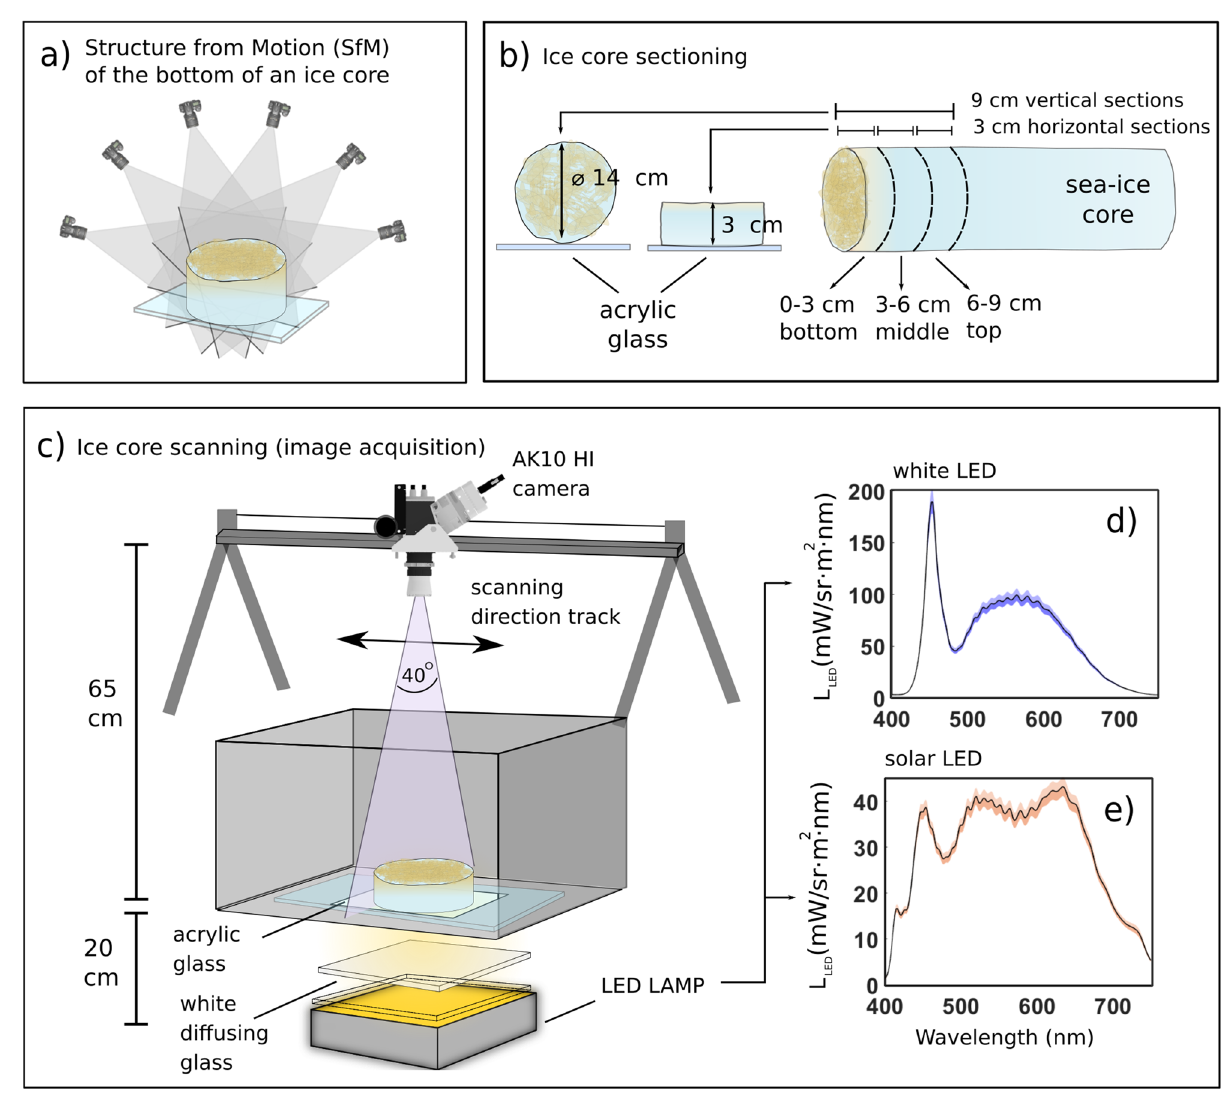
Figure 1. An overview of sample processing and the hyperspectral imaging optical set-up. Specifications and technical details are found in the supplementary material. ( a ) 3D model reconstruction using structure from motion (SfM) digital photogrammetry on horizontal bottom cores sections to retrieve microtopography. ( b ) Vertical and horizontal core samples preparation for hyperspectral image acquisition. A total of 6 vertical scans (of 9 cm length) and 54 horizontal scans (3 cm thick) were acquired in this study. Samples are imaged within a dark box. ( c ) The ice core scanning set-up based on transmitted and artificial homogenously diffuse illumination. AK10 refers to the pushbroom camera model Aisa Kestrel 10 from Specim. ( d ) and ( e ) illustrate respectively the mean ± standard deviation of radiance (L) emitted by the white and solar LED lamps utilised for illuminating the samples. The LEDs were set to emit an E d, PAR of < 30 µmol photons m −2 s −1 to avoid potentially photo-damaging the algal communities, which are typically low-light